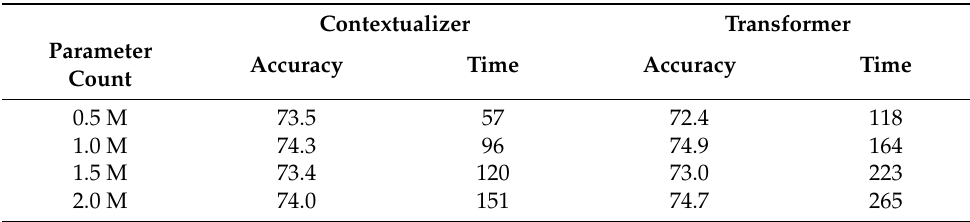
Table 2. Test accuracy (%) on the MR task and computation time (ms/batch) for Transformer and Contextualizer models of similar sizes. The parameter counts exclude word-piece embeddings. The batch size is 32.